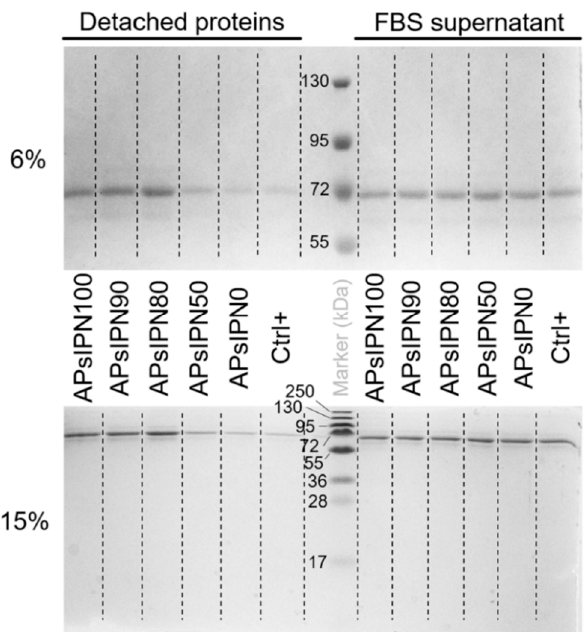
Figure A3. Protein electrophoresis. Coomassie blue-stained gels at 6% (top) and 15% (bottom) acrylamide after SDS–PAGE of serum proteins, either detached from the substrates with loading buffer or diluted 1:100 v/v from the FBS incubation supernatant.